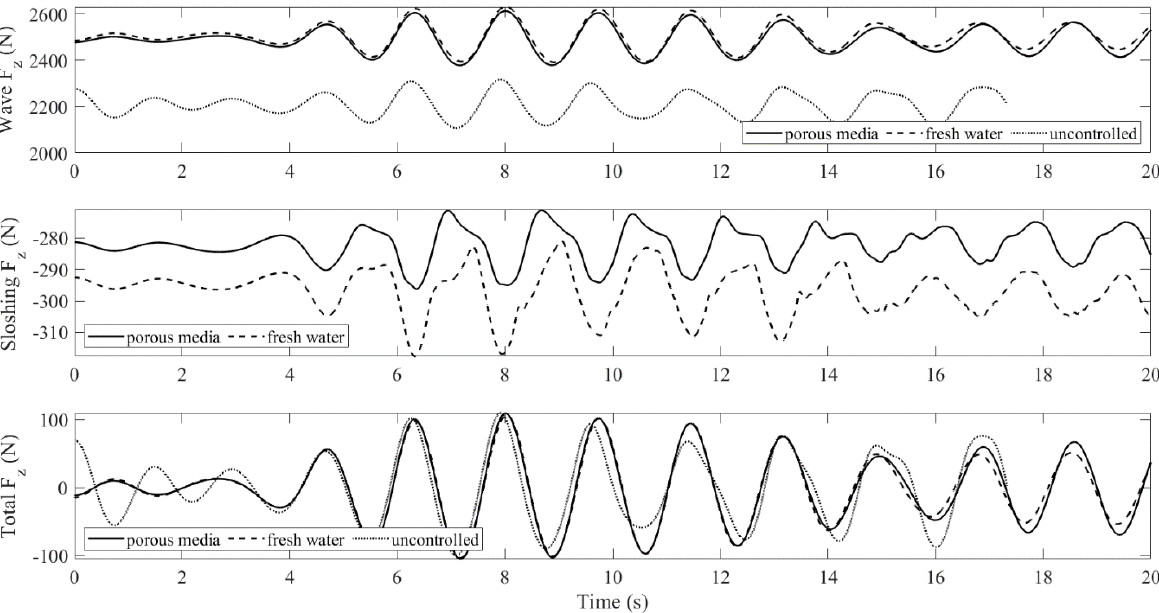
Figure 25. The heave responses of the controlled and uncontrolled floating bodies subject to large wave excitation.